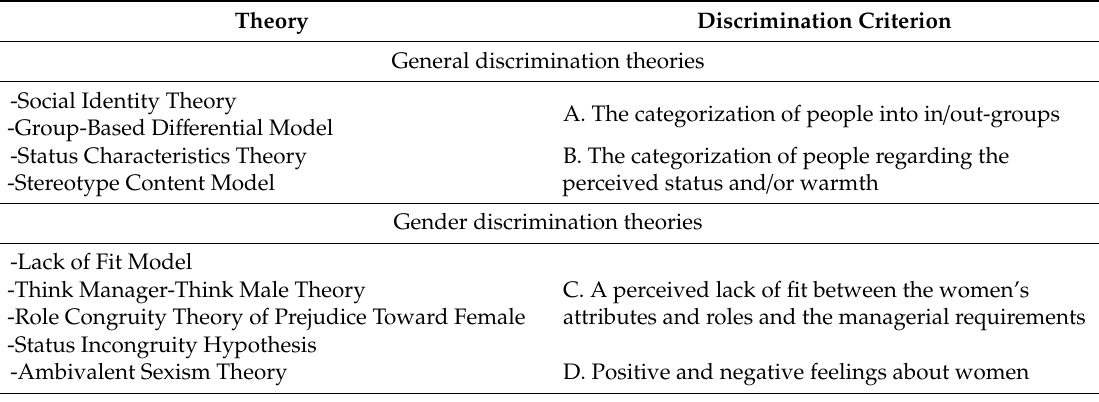
Table 6. Classification of discrimination